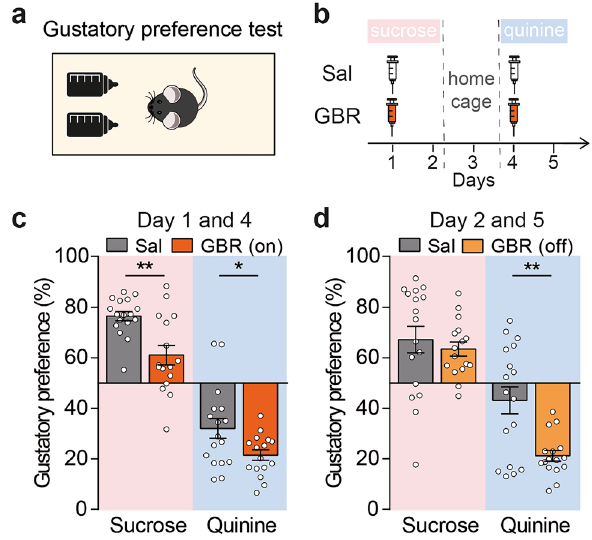
Figure 5. GBR-treated mice show negative hedonic biases in gustatory preference test. ( a ) Scheme of the gustatory preference test. The test occurred in a standard housing cage, with two bottles containing either water or the tastant solution. After one day of habituation with two water bottles, each tastant solution was presented vs water for 48 h. ( b ) Timeline of the injections protocol for the gustatory preference test. Mice were injected at the beginning of the test. ( c , d ) Sucrose is an appetitive tastant in Sal-treated mice both during the first and the last 24 h of test, whereas quinine is aversive for these mice only during the first 24 h (Student or Wilcoxon test vs a theoretical value 50, see also Supplementary Table 2). GBR (on) mice showed a lower preference for both sucrose and quinine solution compared with Sal mice (two-way repeated measures ANOVA, group: F (1,31) = 17.09, p < 0.001, tastant: F (1,31) = 197.8, p < 0.001, interaction: F (1,31) = 0.65, p = 0.426, Holm–Sidak post-hoc test, *p < 0.05, **p < 0.01, n = 16–17). Contrary, GBR (off) mice only exhibited a stronger aversion for quinine, relative to Sal mice for which quinine is not aversive, and no difference for sucrose preference (two-way repeated measures ANOVA, group : F (1,31) = 8.13, p = 0.008, tastant: F (1,31) = 70.69, p < 0.001, interaction: F (1,31) = 5.29, p = 0.028 followed by Holm–Sidak post-hoc analysis, **p < 0.01, n = 16–17). Data are shown as mean ± SEM and individual data